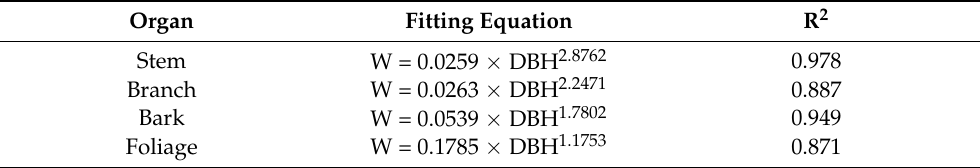
Table 2. Model for estimating aboveground biomass (stem, branch, bark, and foliage) of